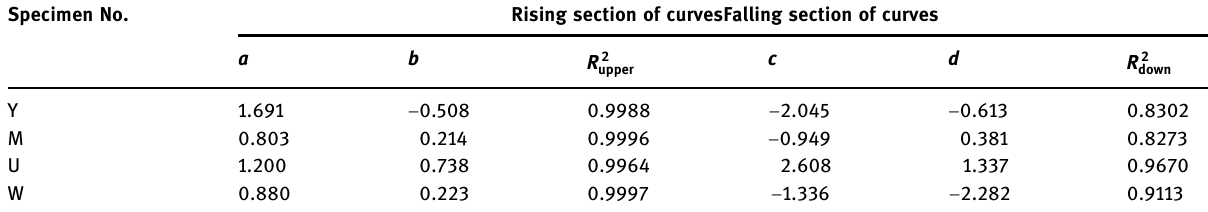
Table 4: The parameters of stress – strain curves equation Specimen No.